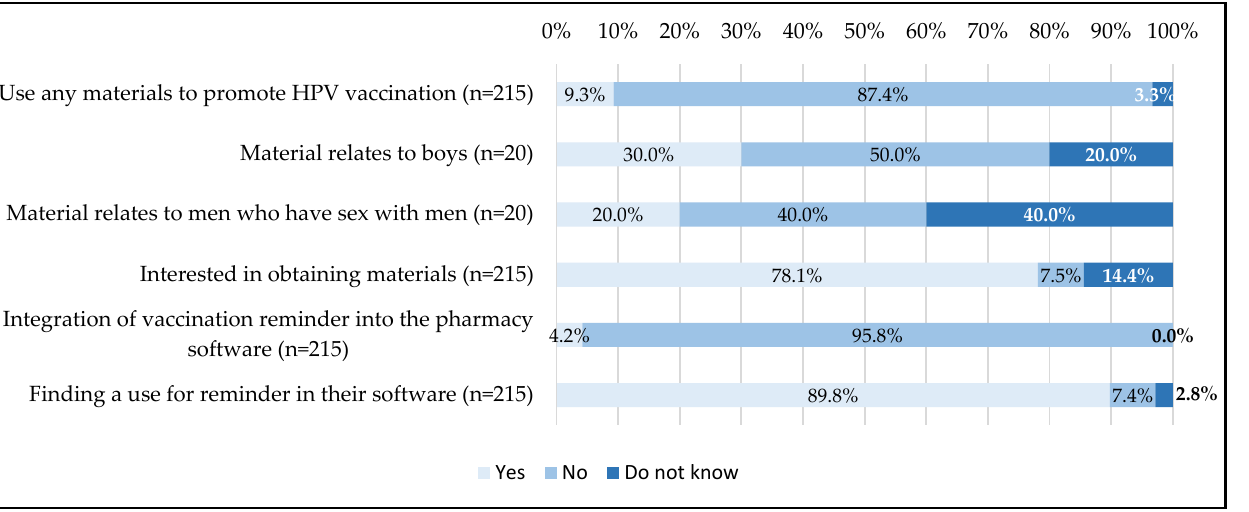
Figure 3. Pharmacists’ use and interest in materials and aids for HPV vaccination promotion. 87.4% (n = 188) did not use promotional materials but 78.1% (n = 168) of respondents